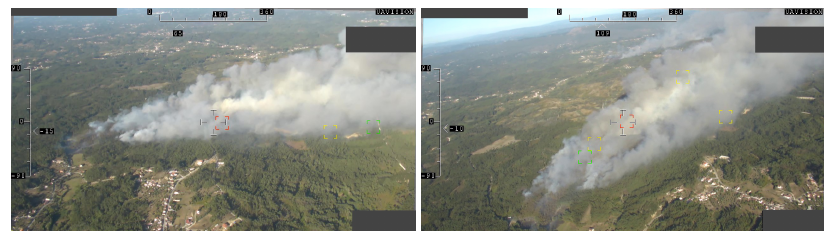
Figure 19. Sample frames of the Pombal